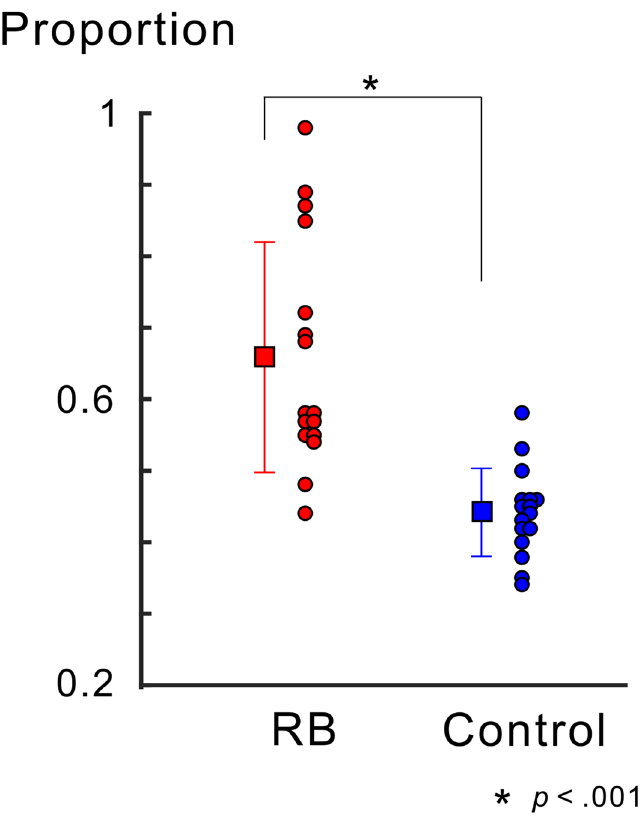
Figure 2. Proportion of trials in which a perceived facing-orientation of the Necker lattice was opposite to that of the adaptor. The proportions of trials in which the Necker lattice was perceived as an upper-left-facing lattice (opposite orientation to that of the adaptor) are shown for all participants. The mean proportion is indicated by a black square with ± SD. The proportion in the RB condition was significantly higher than that in the Control condition. Some individual data points are horizontally shifted for display purposes. As in the other figures, data for the RB condition and that for the Control condition were depicted in red and in blue,